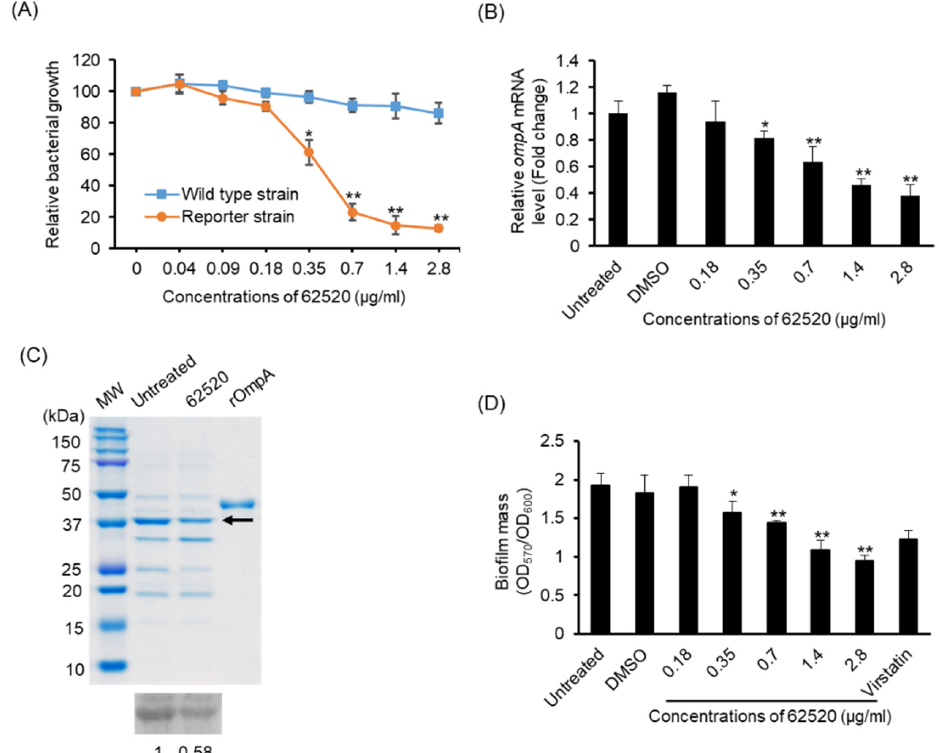
Figure 1. Activity of compound 62520 at sub-inhibitory concentrations. ( A ) The WT A. baumannii ATCC 17978 and reporter strain OH101 were treated with different concentrations of compound 62520 for 24 h and bacterial growth was measured at OD 600 . The relative bacterial growth was determined by the OD 600 in each concentration of compound 62520 relative to the OD 600 in the control (0 µ g/mL). Data are presented as the mean ± SD of three independent experiments. ( B ) A. baumannii ATCC 17978 was treated with different concentrations of compound 62520 for 24 h and then total RNA was extracted. The expression levels of ompA were analyzed by qPCR. Data are presented as the mean ± SD of the expression levels of ompA in A. baumannii ATCC 17978 treated with compound 62520 relative to those of untreated control bacteria. Data were obtained from three independent experiments. ( C ) SDS-PAGE and western blotting of the outer membrane fractions in A. baumannii ATCC 17978. The arrow indicates the OmpA protein. The values in western blotting represent the intensity of bands relative to the intensity of untreated bacteria. ( D ) A. baumannii ATCC 17978